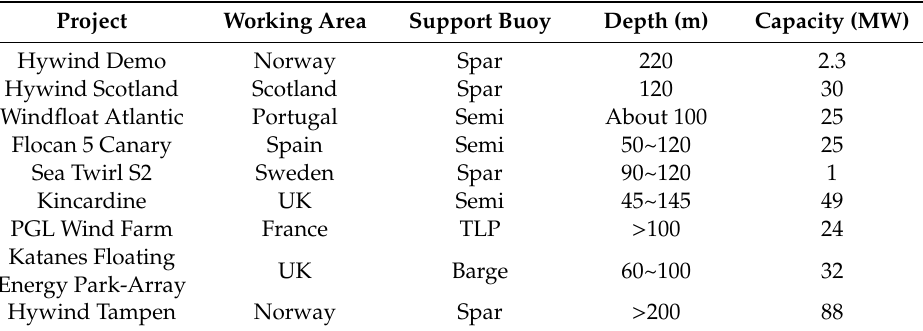
Table 1. O ff shore wind farms in